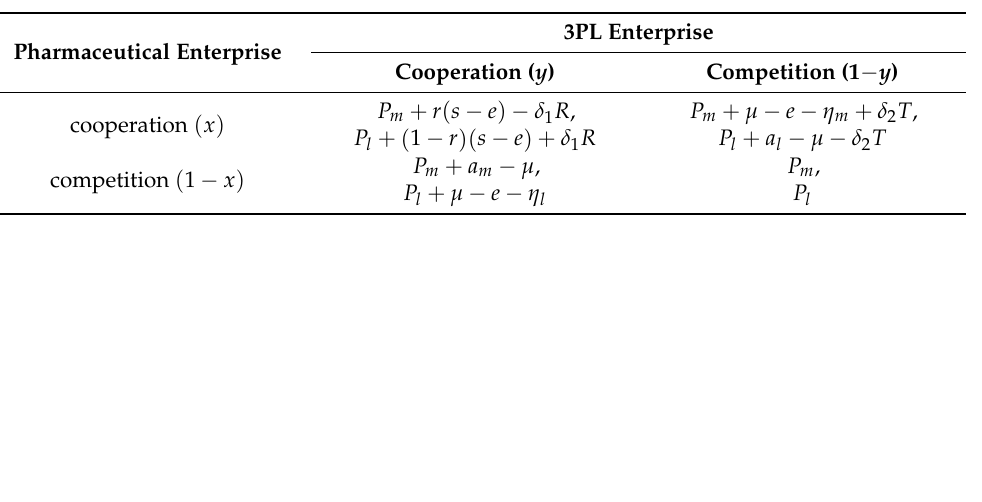
Table 2. Income matrix of co-opetition of medical product distribution in